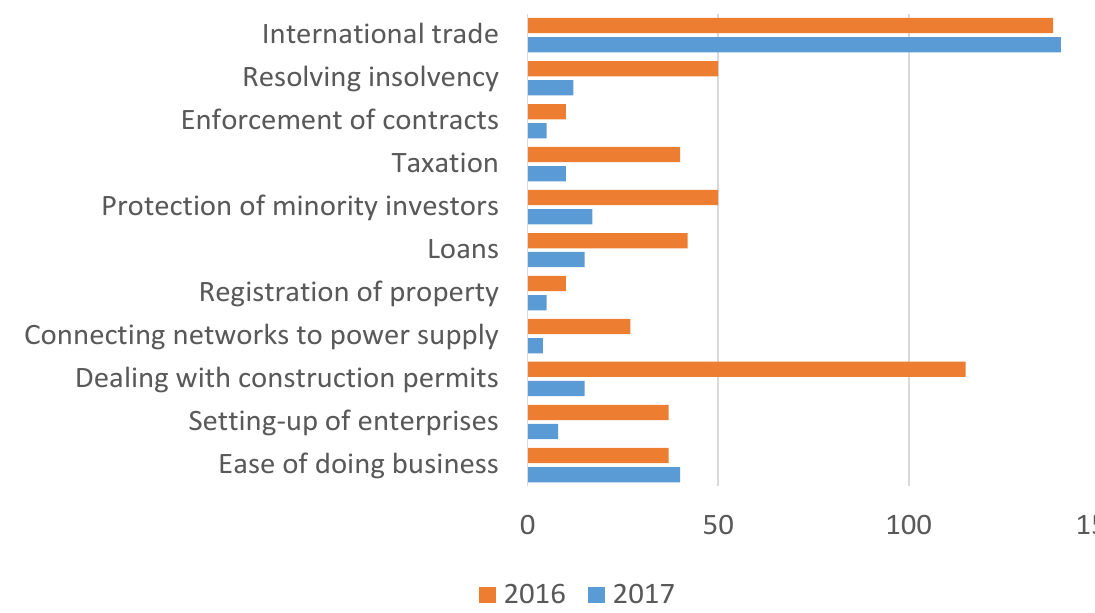
Figure 2. The place of Russia in the ranking on ease of doing business